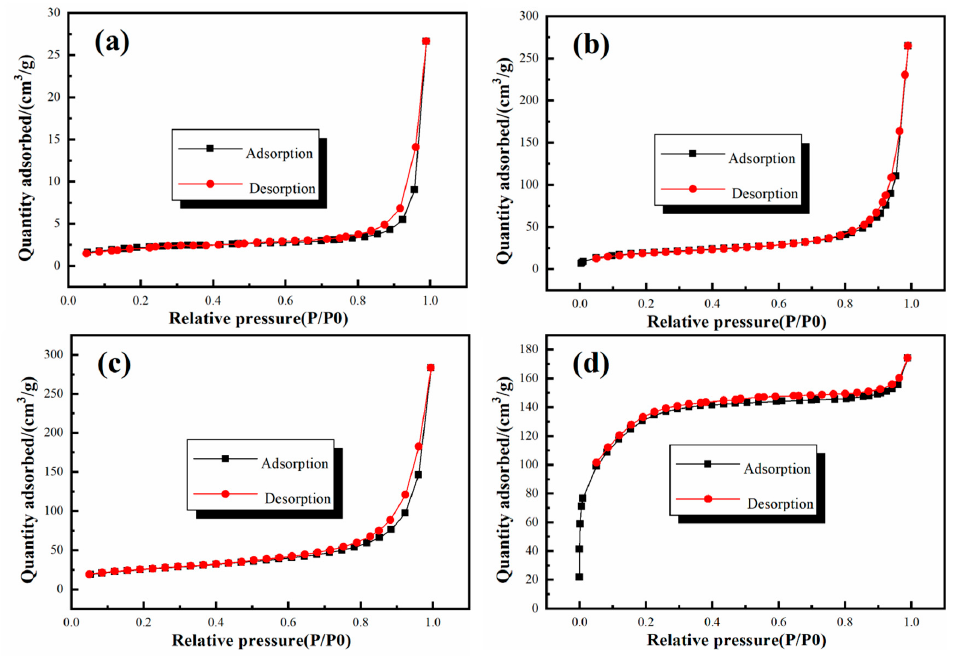
Figure 3. Nitrogen adsorption–desorption isotherms of ( a ) SiO 2 , ( b ) GS-1, ( c ) GS-2, ( d ) GS-3.